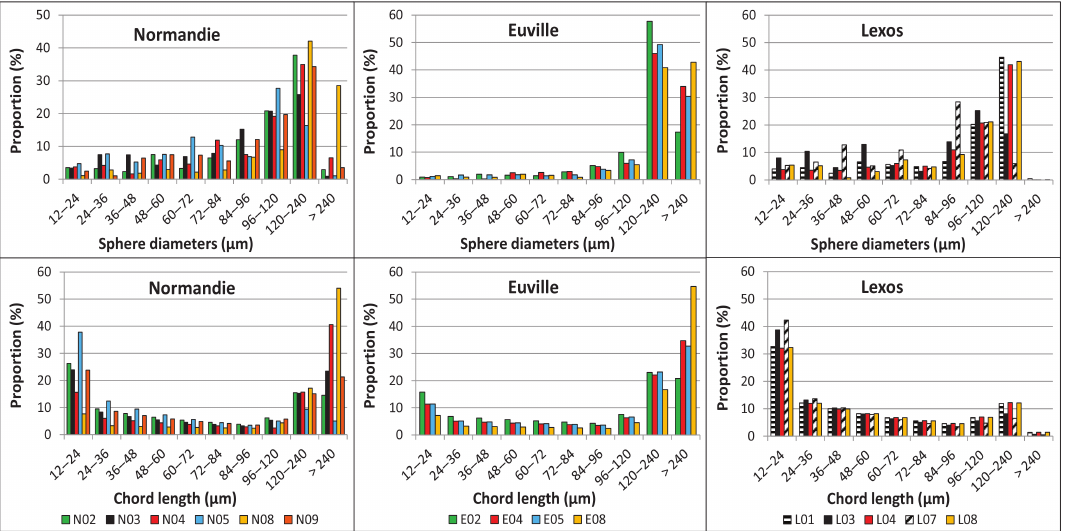
Figure 5. Pore size distribution obtained by sphere diameters calculations (on the top) and mean chord lengths calculations (on the bottom), using imaging software. Normandie samples are displayed on the left part, Euville on the central part and Lexos is shown on the